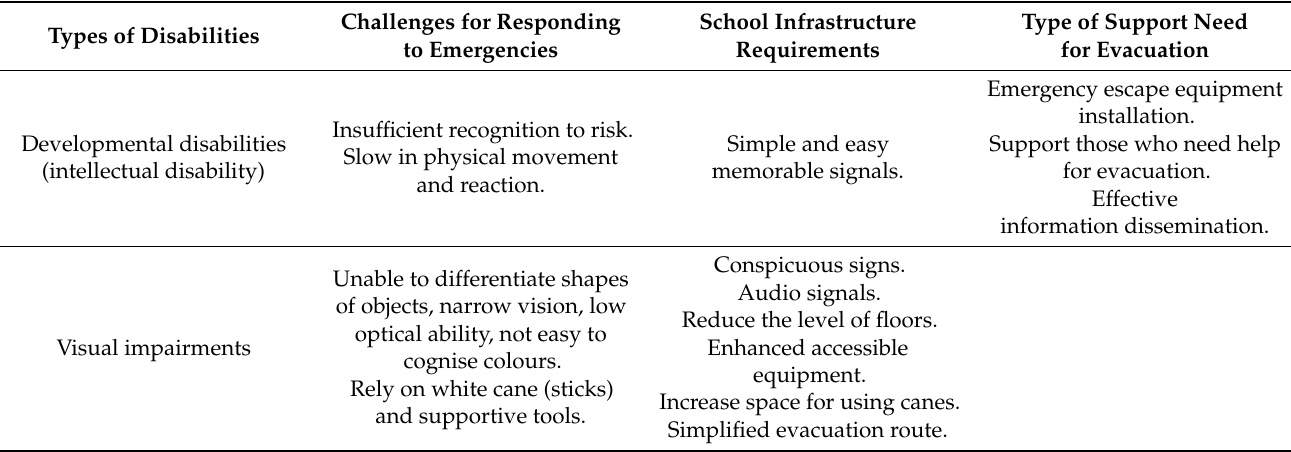
Table 1. Challenges and requirements of school infrastructure for students with different types of